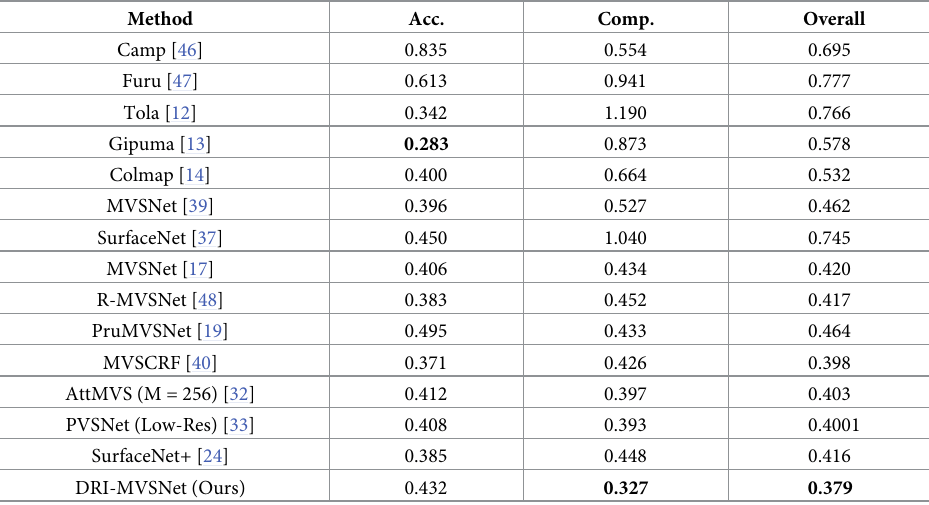
Table 2. Quantitative results on the DTU dataset (lower is better).